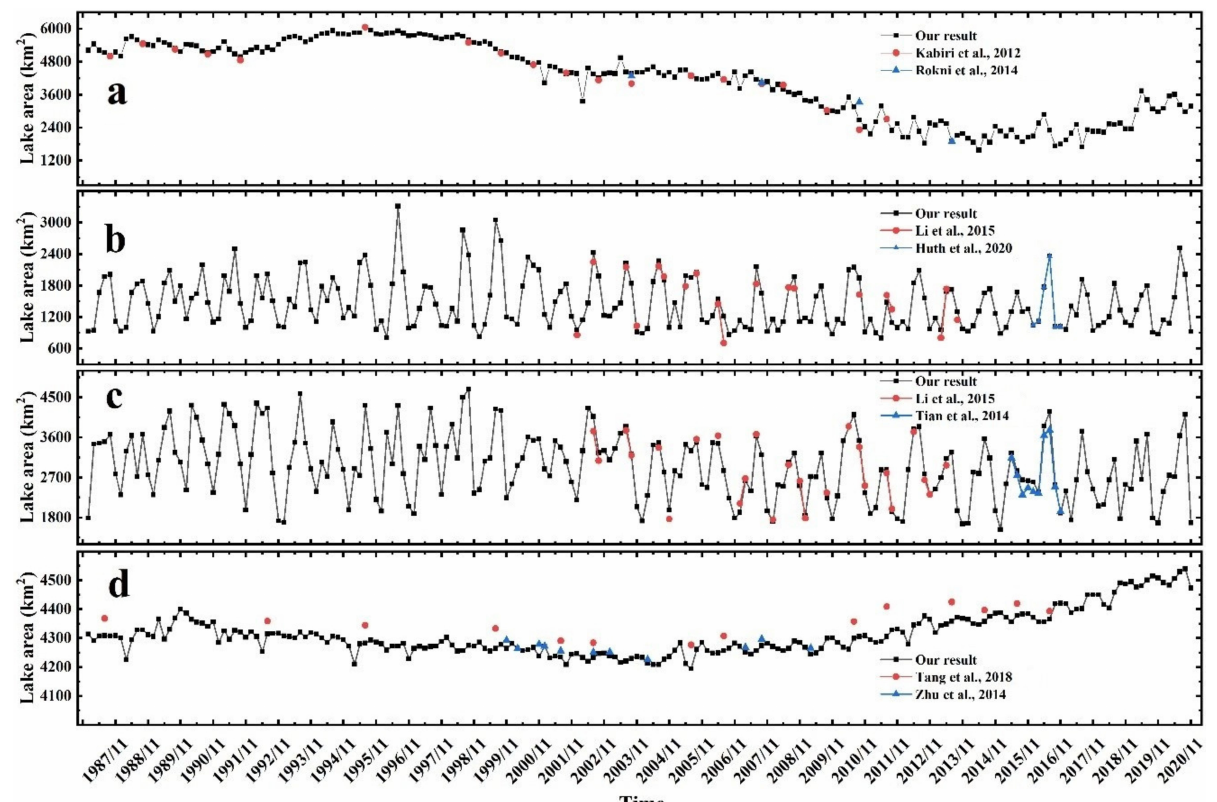
Figure 9. Comparison of our results with those of others. ( a ) Urmia Lake [69,70]; ( b ) Dongting Lake [72,73]; ( c ) Poyang Lake [71,72]; and ( d ) Qinghai Lake